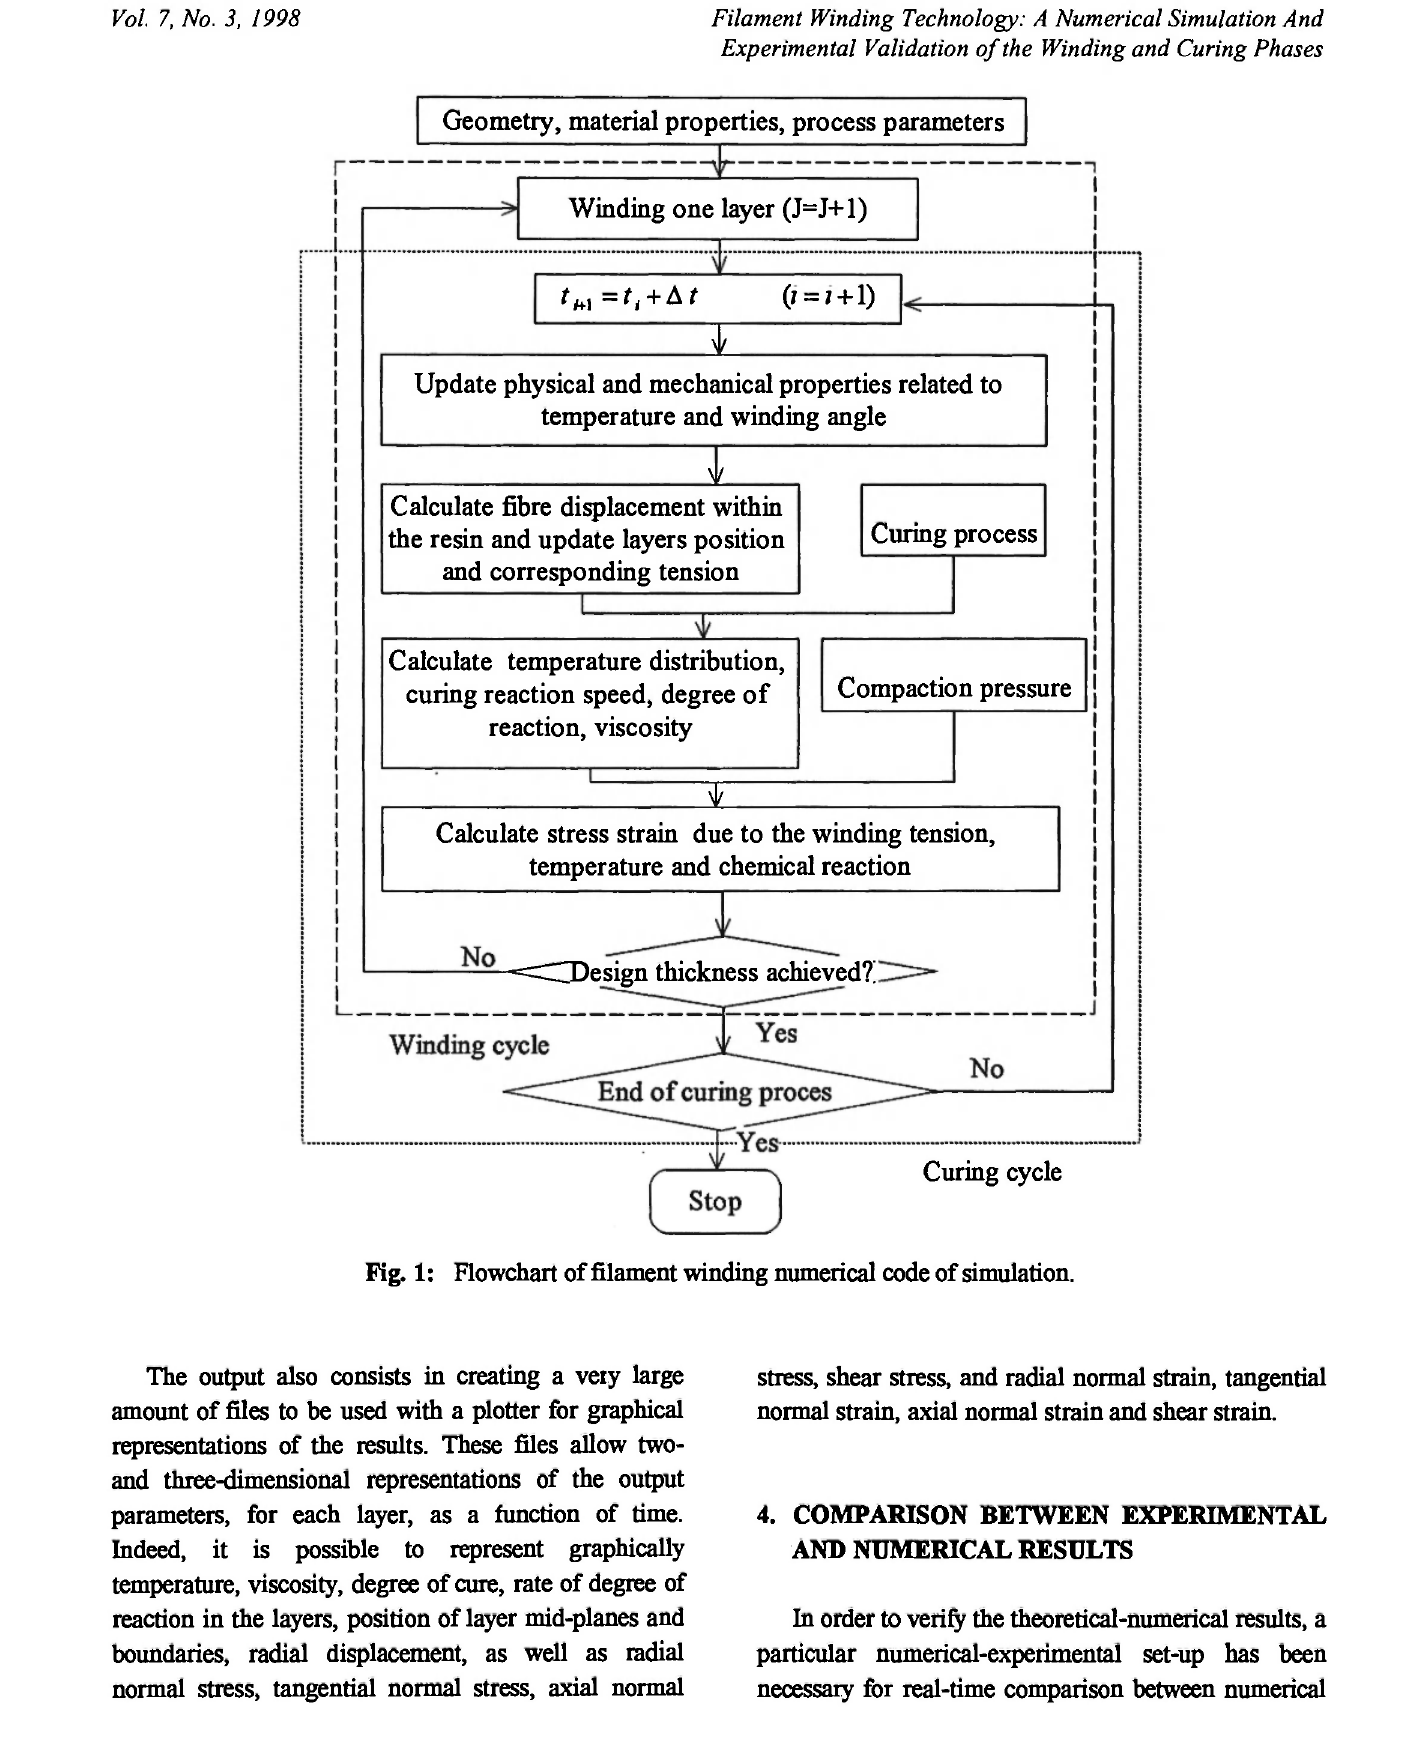
Fig. 1: Flowchart of filament winding numerical code of